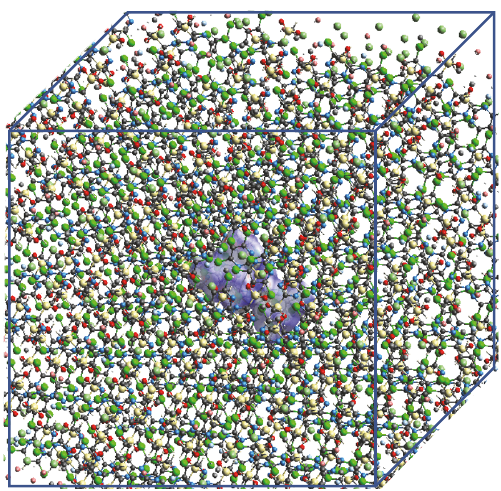
Figure 12: Schemeof thebulk representingtheembedded